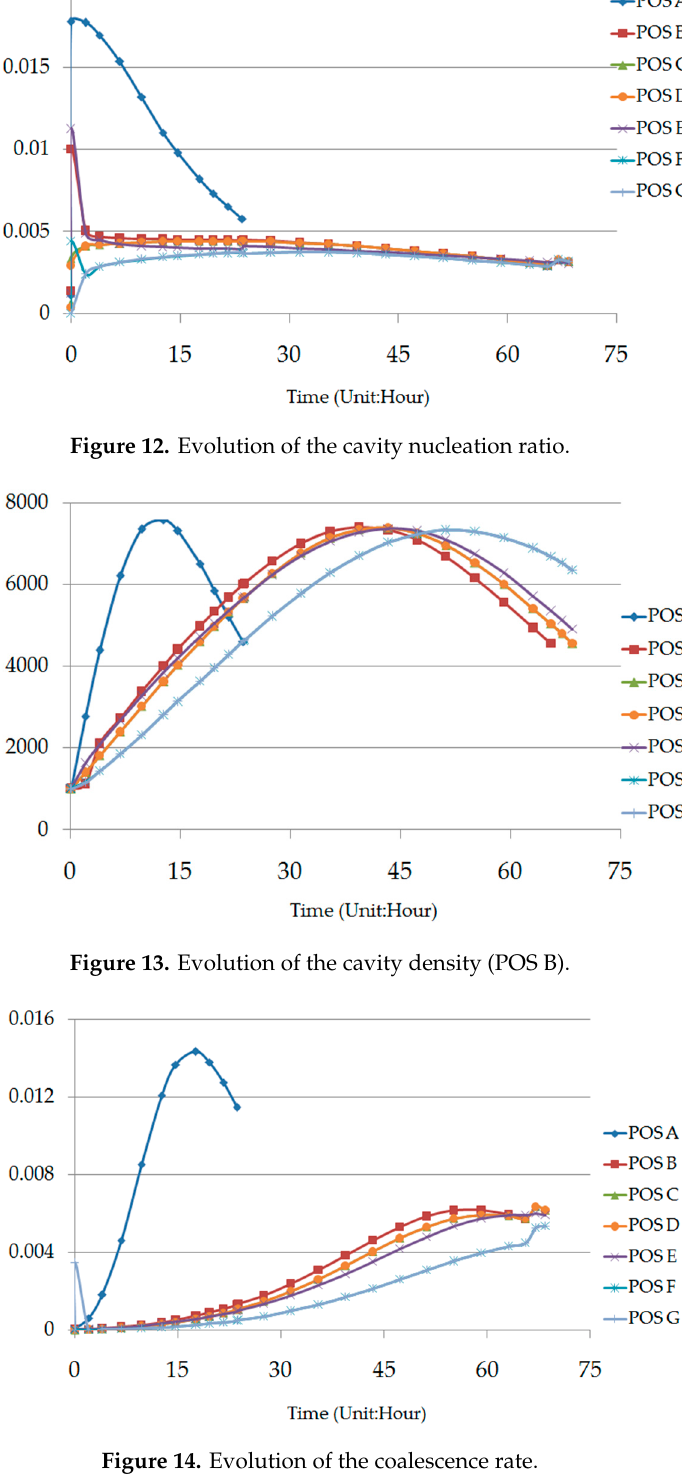
Figure 14. Evolution of the coalescence rate.